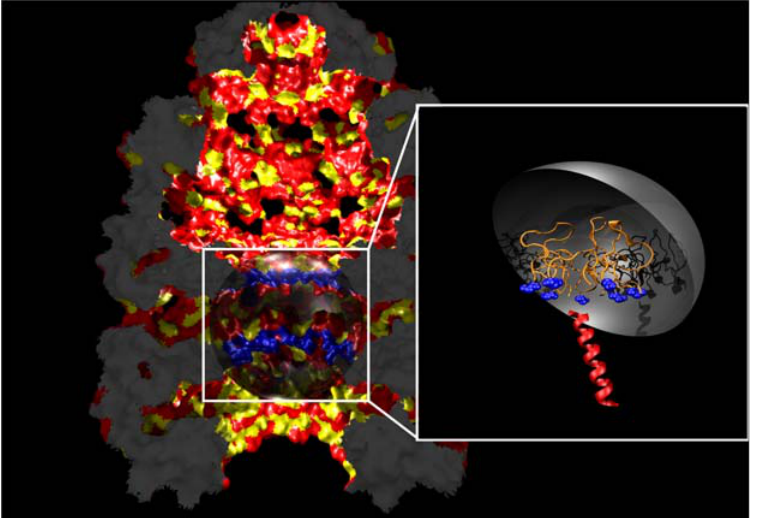
Figure 1. Space-filling representation of the X-Ray structure of the GroEL/GroES/ADP complex [ 5 ] . Colours represent the type of surface: all hydrophobic amino acids (A, V, L, I, M, F, P, Y) are in yellow , while the polar ones (S, T, H, C, N, Q, K, R, D, E) are red . The sphere in the equatorial region has a radius of 40 A˚ and models the cavity between the cis and the trans chamber. In the inset we show the actual simulation setup, consisting of: the confining sphere, the chains (orange) anchored the GroEL amino acids in the equatorial region (blue), and a test alpha helix (red) allowed only to rotate around the center of mass, and to translate.